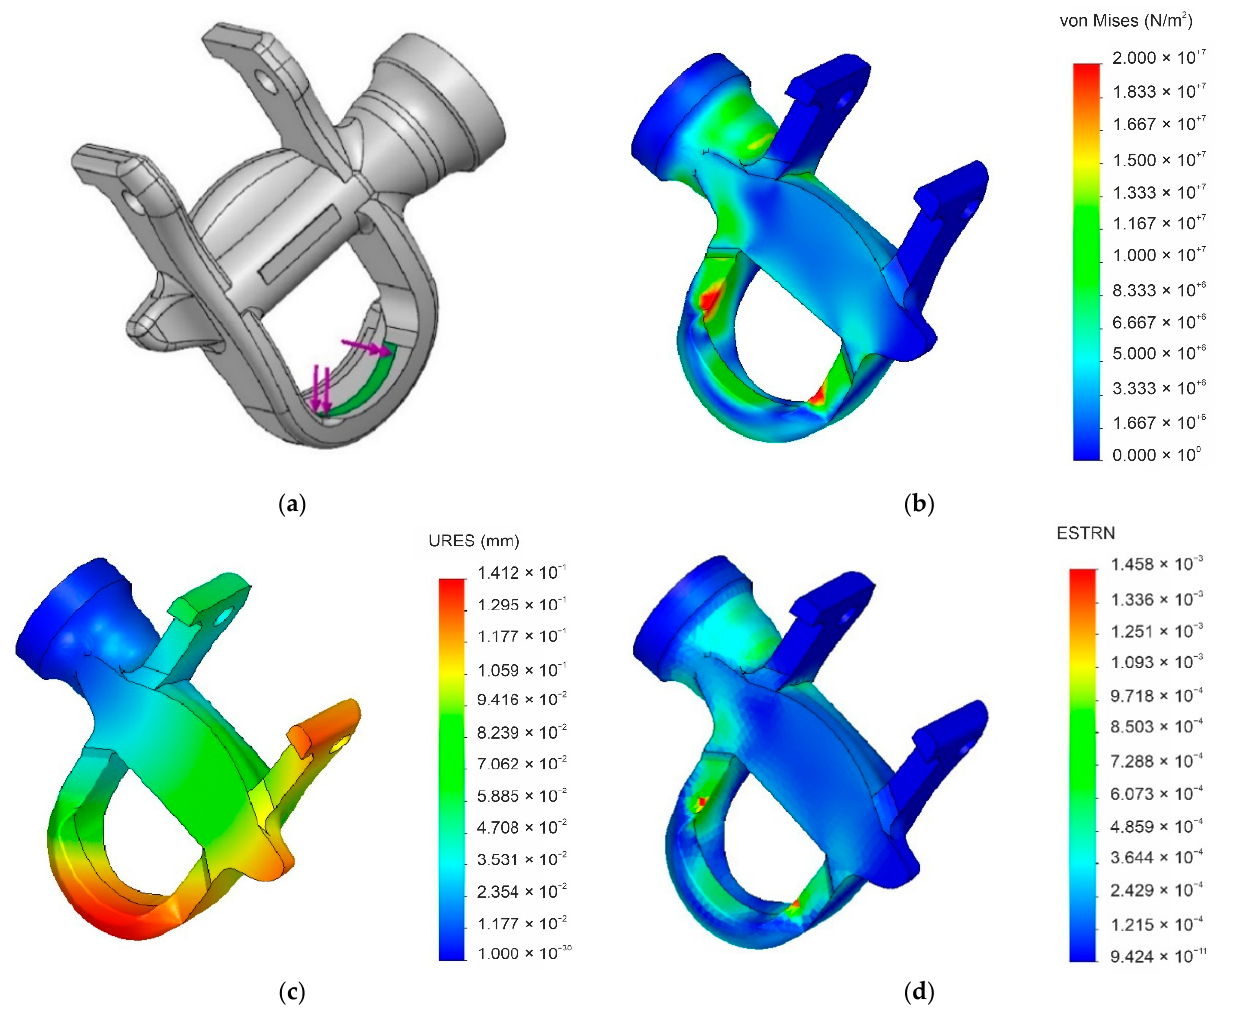
Figure 3. Graphic output summaries of the finite-element analysis of a PA11 + 60% SGW pedal body during cleat engagement under extreme use conditions. ( a ) Loaded surface; ( b ) Von Mises stress; ( c ) net displacement; ( d ) percent strain.